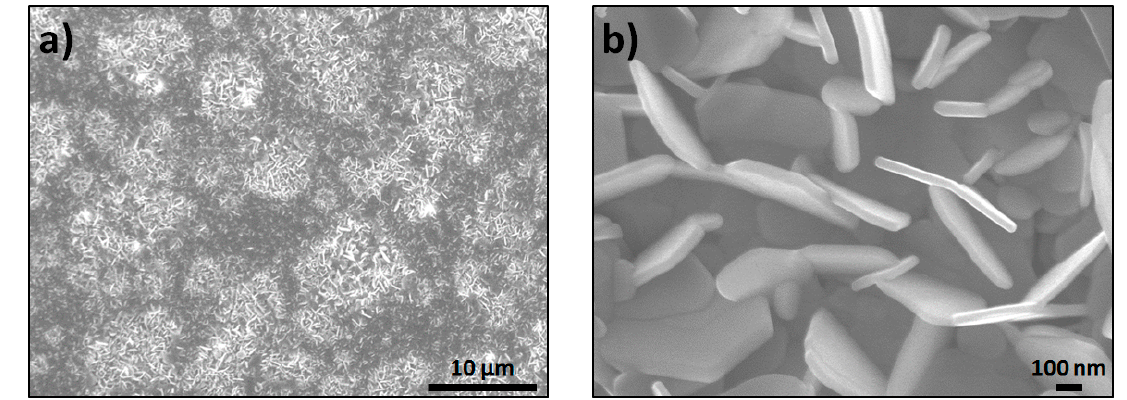
Figure 1. SEM images of tungsten diselenide (WSe 2 ) with ( a ) low and ( b ) high magnification (×2500 and ×60,000, respectively).